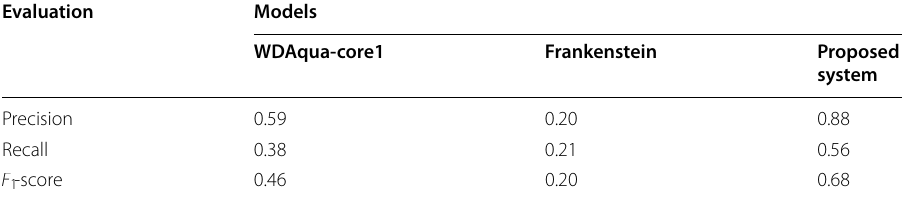
Table 5 End-to-end performance on the LC-QuAD dataset